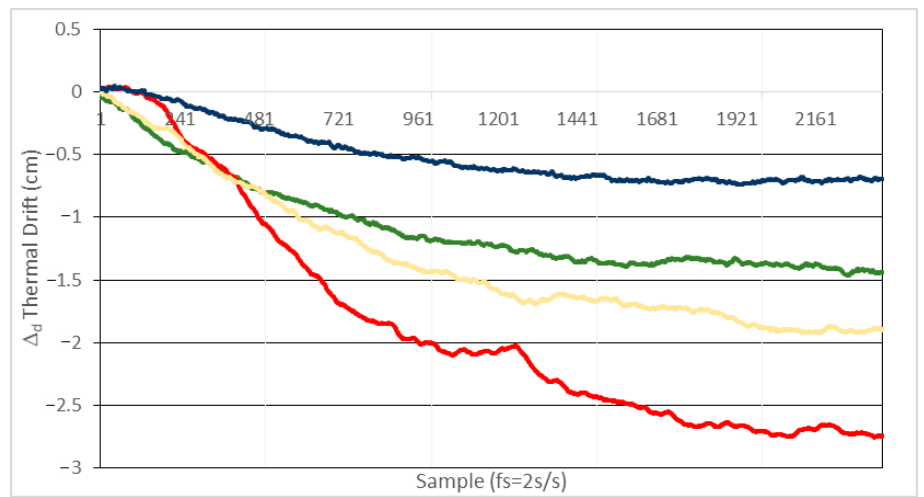
Figure 9. Distance error due to phase thermal drift with Cf = 1.2 pF and temperature increment from 25 ° C to 35 ° C (+10 ° C). Blue line: Rf = 3.9 K Ω , green line: Rf = 6.8 K Ω , orange line: Rf = 12 K Ω and red line: Rf = 22 K Ω .